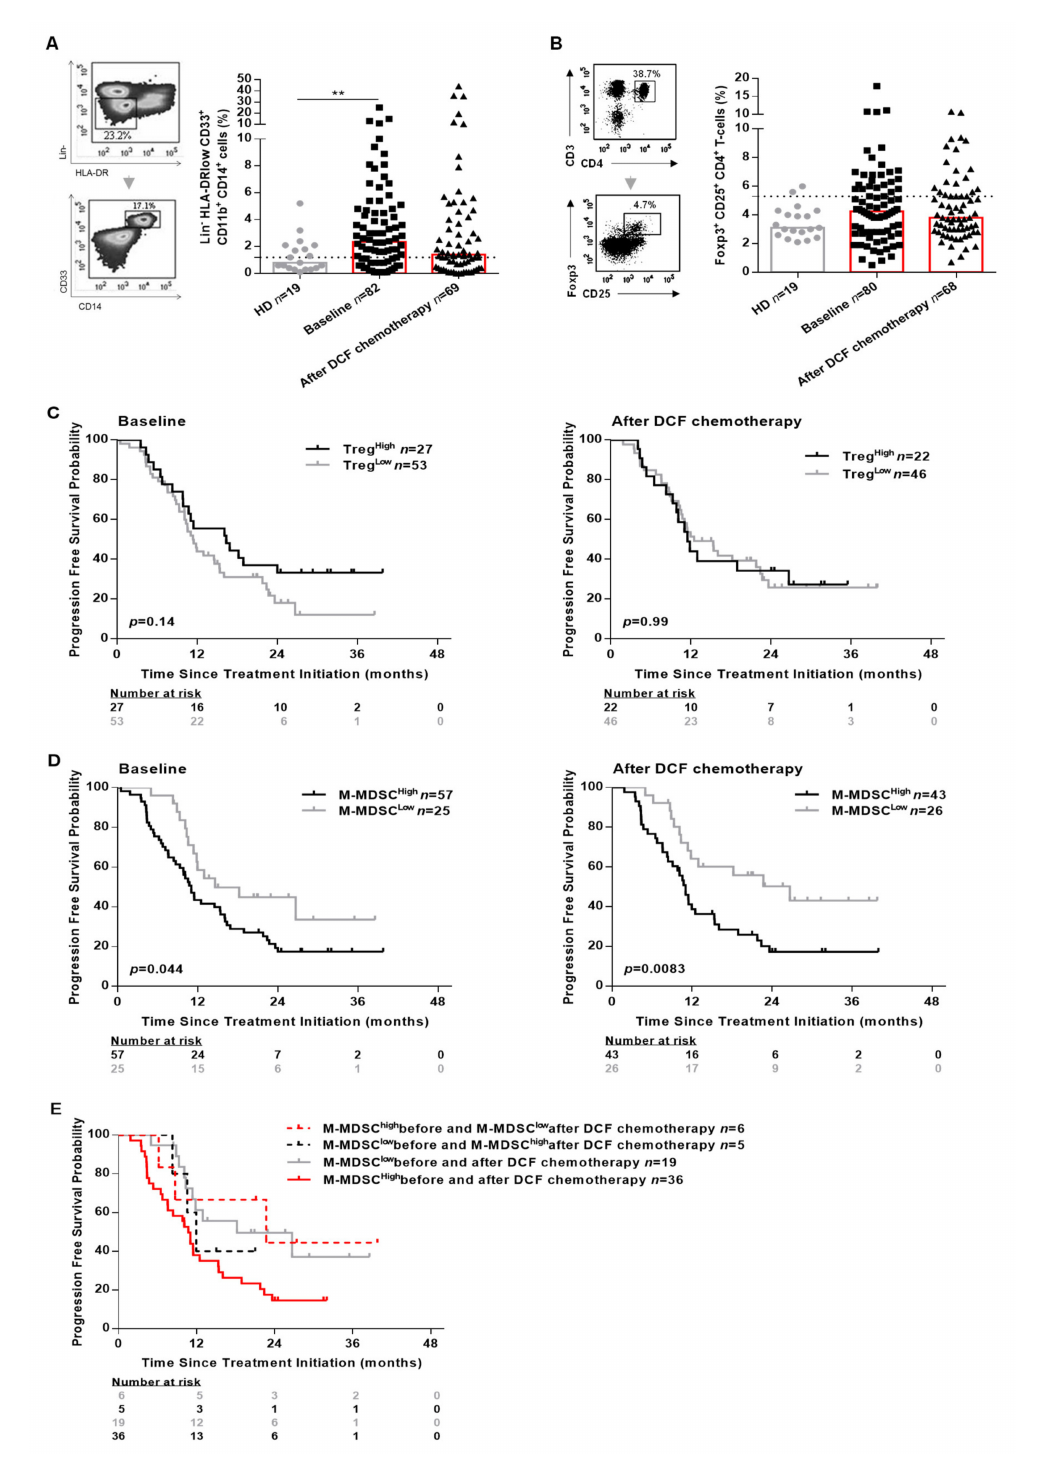
Figure 3. M-MDSC levels and not Treg levels are associated with the clinical outcomes in SCCA patients. PBMC from 19 healthy donors and SCCA patients before ( n = 82) and after ( n = 69) DCF chemotherapy were analyzed for Treg and M-MDSC population by flow cytometry. ( A ) Frequencies (%) of M-MDSC. ( B ) Frequencies (%) of CD25 + Foxp3 + expressed on CD4 + T-cells. ( C ) Kaplan-Meier survival curve in SCCA patients before and after DCF chemotherapy according to Treg levels. ( D ) Kaplan-Meier survival curve in SCCA patients before and after DCF chemotherapy according to M-MDSC levels. Log-rank test, where ** p < 0.01. ( E ) Kaplan-Meier curve in distribution of M-MDSC levels in SCCA patients treated by DCF